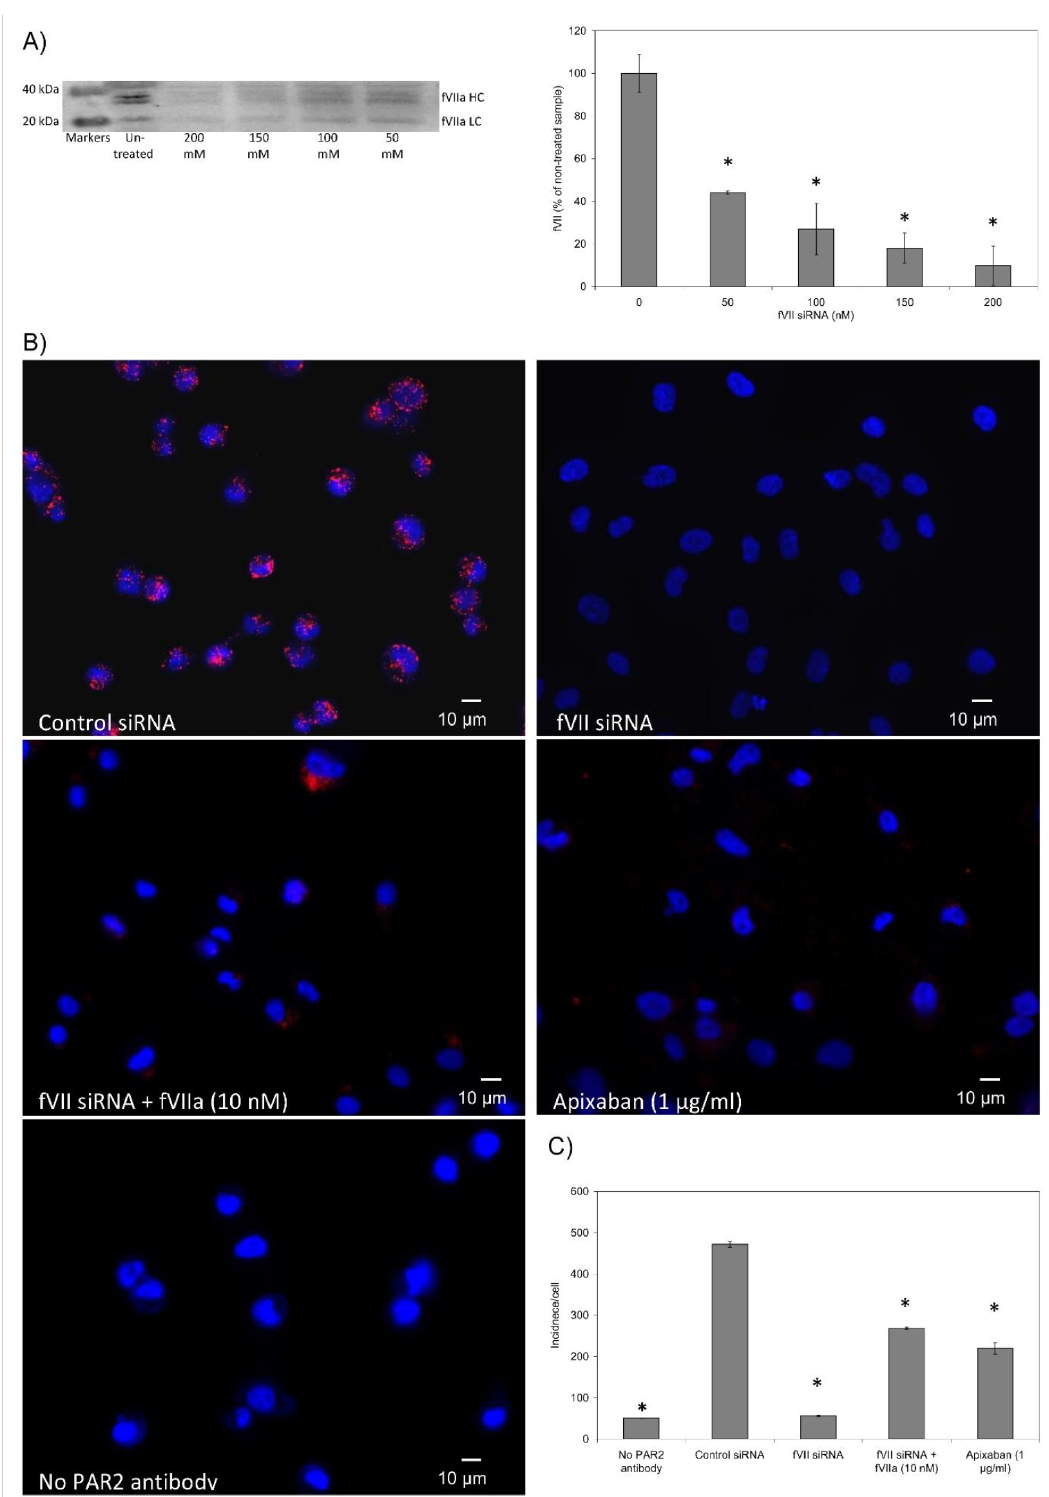
Figure 3. Analysis of the association of TF and PAR2 in the presence and absence of fVIIa: Sets of MDA-MB-231 cells (10 5 ) cells were transfected with a set of Silencer Select Pre-designed siRNA specific for the coagulation factor VII or a control siRNA (200 nM) using Trans IT-2020 transfection reagent and incubated for 48 h at 37 ◦ C. ( A ) The knock-down was optimised beforehand by Western blot using a rabbit polyclonal anti-fVII antibody 1:2000 ( v / v ) and developed with a goat anti-rabbit antibody 1:4000 ( v / v ) (also see Figure S4). The membranes were analysed by the ImageJ program to determine the level of expression of fVII as well as the active subunits of fVIIa protein. ( n = 3; * = p < 0.05 vs. Non-transfected